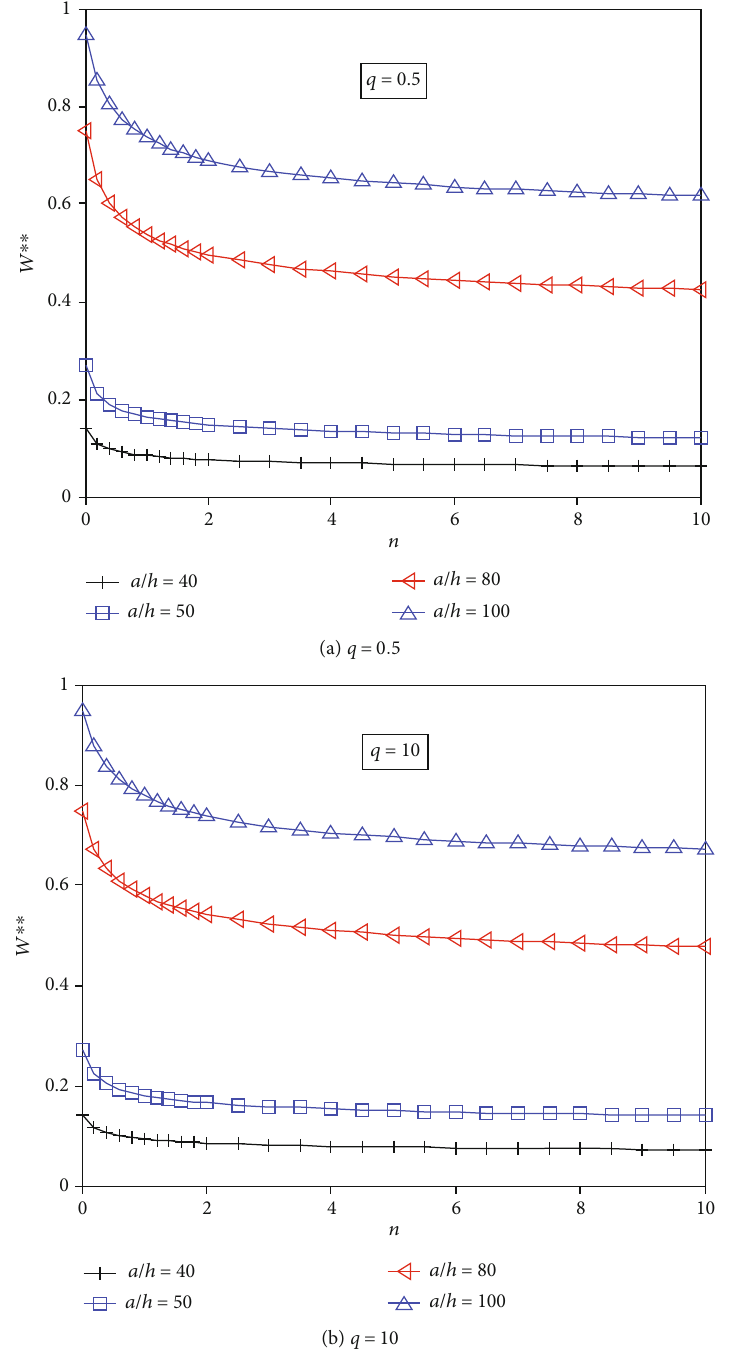
Figure 6: The maximum of de fl ection in two cases of q